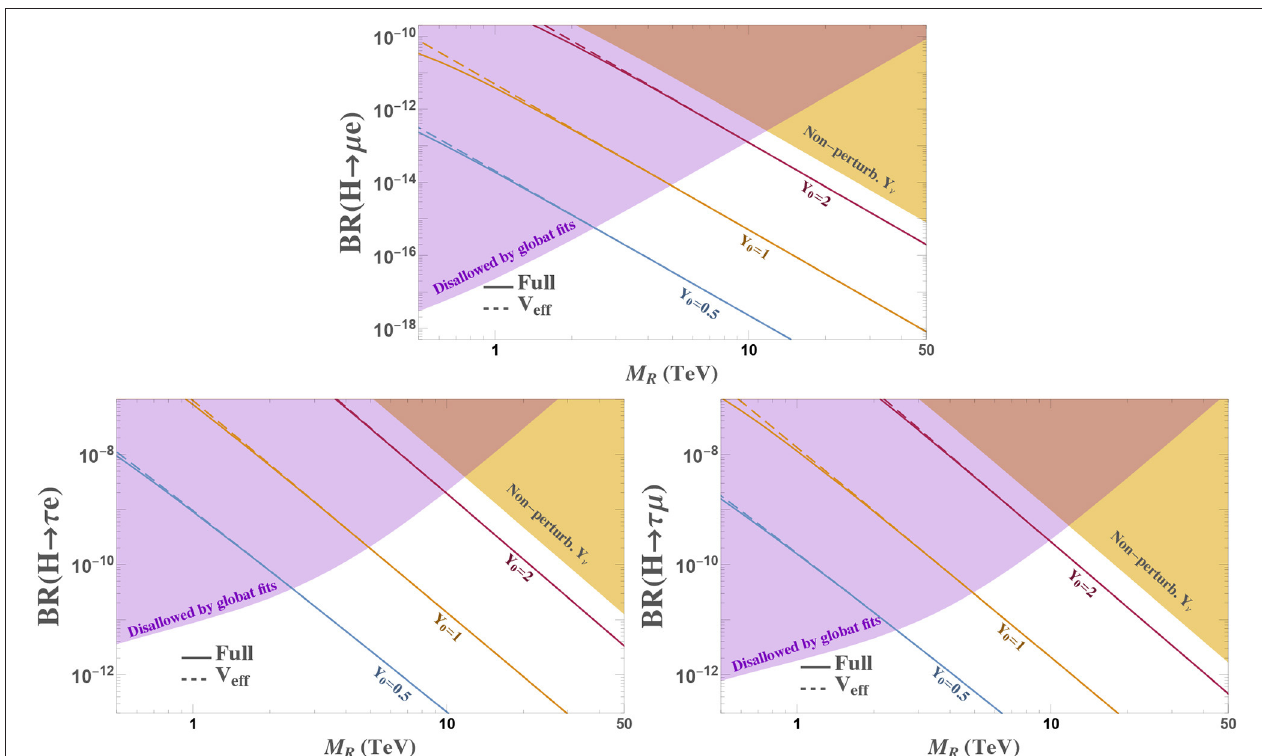
FIGURE 8 | Predictions for the Higgs boson decays into µ e (top), τ e (left) and τµ (right) computed with the effective vertex in the MIA (dashed lines) and the full results in the physical basis (solid lines) in the context of a low scale seesaw model with Yukawa coupling Y LSS given by Equation (50). Shadowed areas are disallowed by global fits constraints (purple) and the non-perturbative regime for the Yukawa couplings (yellow), which we define as